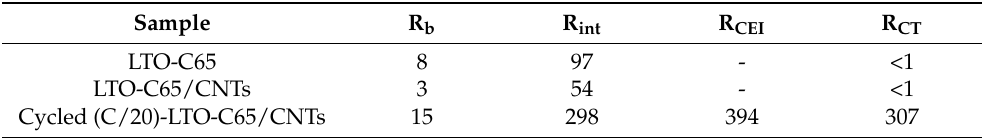
Table 1. Resistances of the different components obtained from the Li metal full cells assembled with the two electrodes: ionic bulk conductivity (R b ), electrode interfaces (R int ), cathode solid electrolyte interface resistance (R CEI ) and charge transfer resistance for electrochemical reactions (R ct ). The resistances are calculated from the equivalent circuit before cycling of the cells and for the LTO-C65/CNTs cell after 140 cycles at C/20. Values are given in Ohms. Sample R b R int R CEI R CT LTO-C65 8 97 - <1 LTO-C65/CNTs 3 54 - <1 Cycled (C/20)-LTO-C65/CNTs 15 298